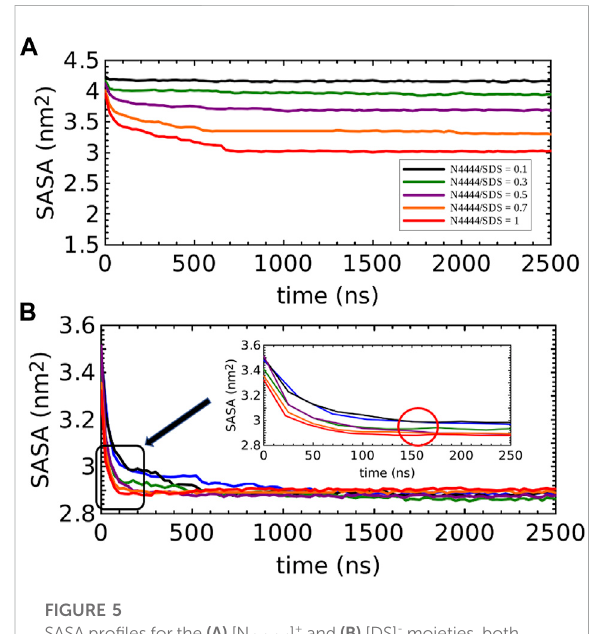
FIGURE 5 SASA pro fi les for the (A) [N 4,4,4,4 ] + and (B) [DS] - moieties, both for all 0.0, 0.1, 0.3, 0.5, 0.7, and 1.0 [N 4,4,4,4 ] + /[DS] - molar ratio systems shown in Figure 2. The inset in Figure 5B zooms in the SASA pro fi les in the fi rst 250 ns of simulation whilst the red circle guide the eye to emphasize the shift experienced for the 0.5 [N 4,4,4,4 ] + /[DS] - ratio solution towards the SASA values of the clusters observed in the 0.7 and 1.0 solutions at 160 ns. SASA pro fi lein (B) fortheSDSsolutionwithout[N 4,4,4,4 ] + isshowninblue